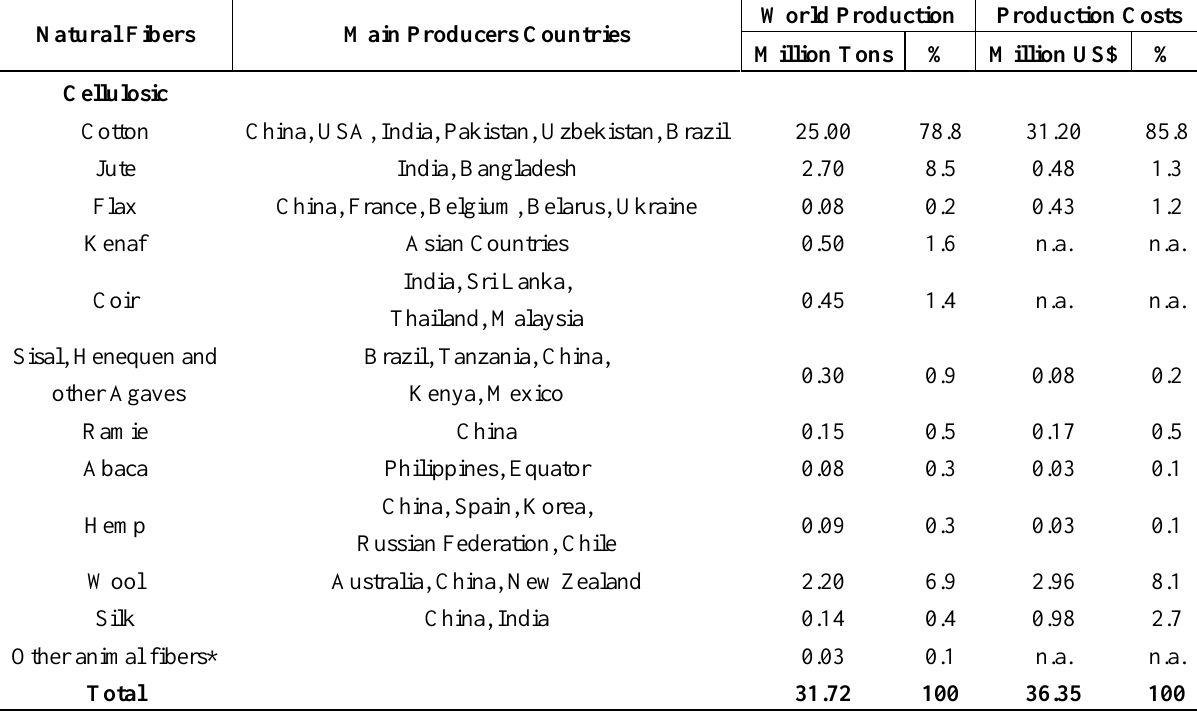
Table 1. Estimated global production and costs of natural fibers (2003–2005).